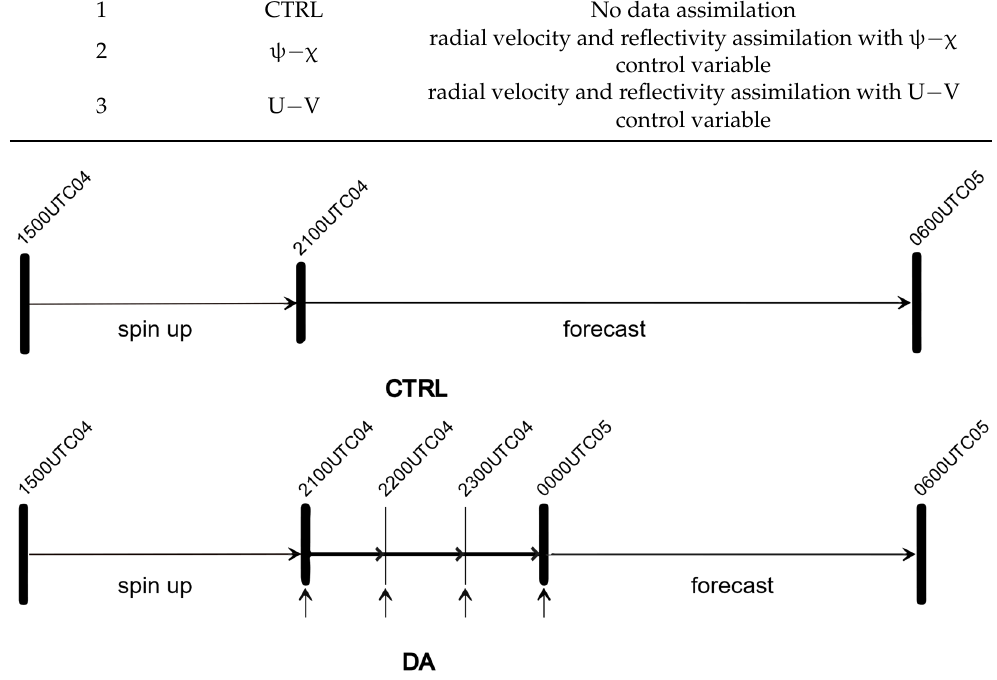
Figure 3. The flow chart for the data assimilation experiments.